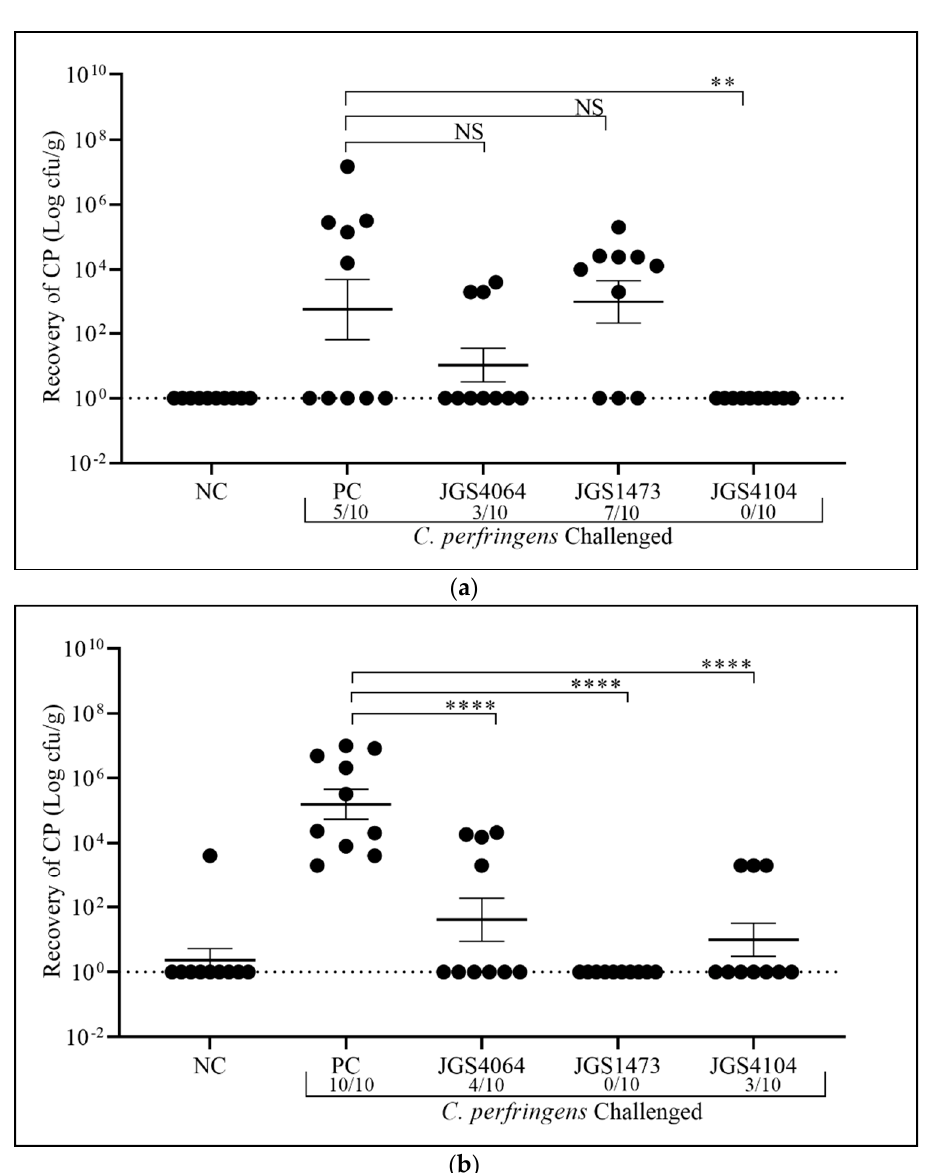
Figure 4. Prevention of C. perfringens (CP) colonization by eBeam-killed vaccine as determined by bacterial counts in ileal contents. Birds in all groups were inoculated with 1 × 10 7 CFU of CP via oral gavage. Horizontal bar represents mean ± standard error. Birds were necropsied four days after post-challenge (day 22 for early-challenge and day 29 for late-challenge), and C. perfringens counts in ileal contents were determined ( n = 10 in each groups). Significant difference in values, ** p < 0.01 and **** p < 0.0001, was determined by one-way analysis of variance (ANOVA) and NS = not significant. PC = Positive control; NC = Negative control. ( a ) Early challenge and ( b ) late challenge.